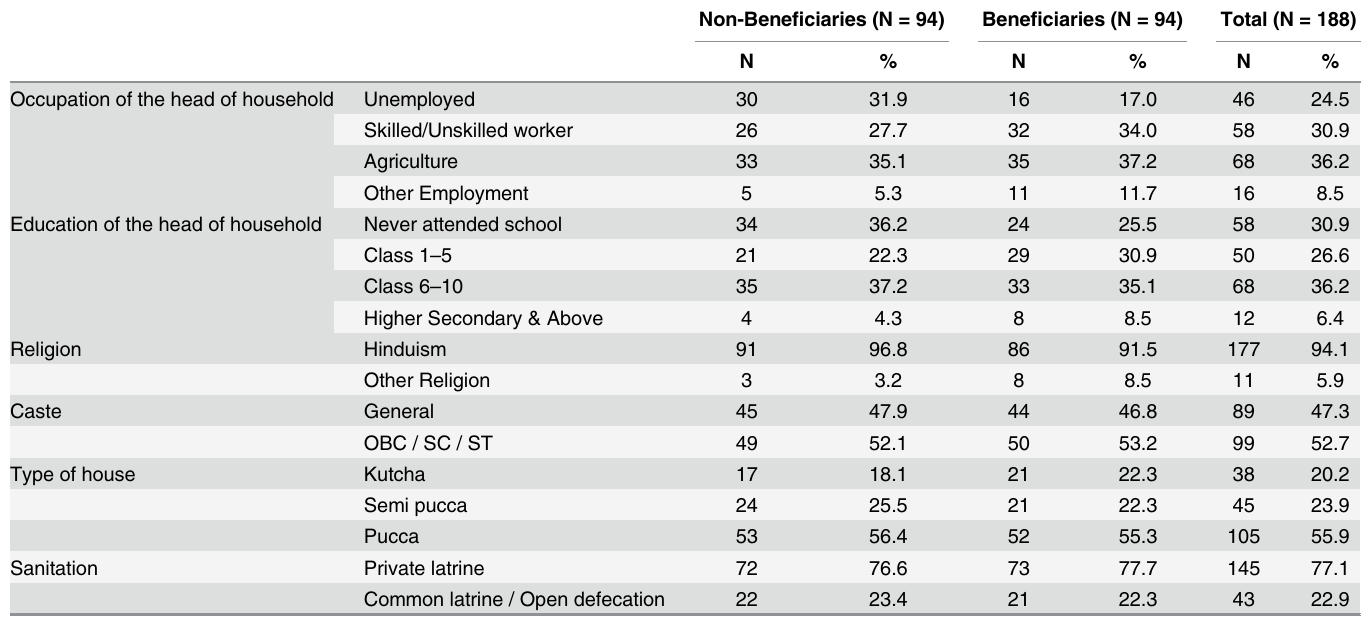
Table 1. General characteristics of households of non-beneficiaries and beneficiaries, Solan, Himachal Pradesh, India,